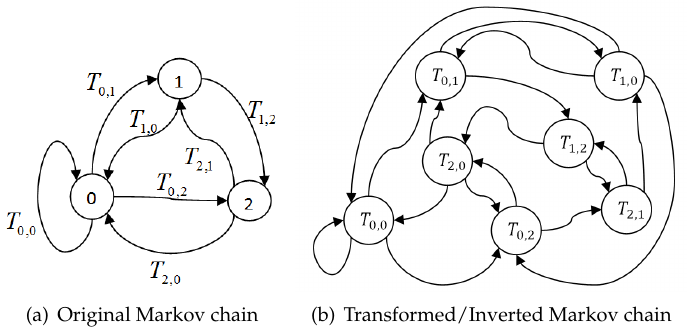
Figure 6. Transformation of sample M/M/1/2